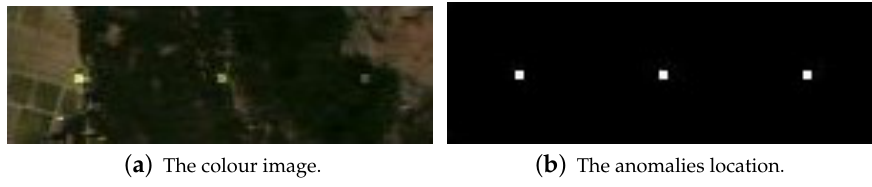
Figure 3. The colour image and the ground truth image of Cloverdale data